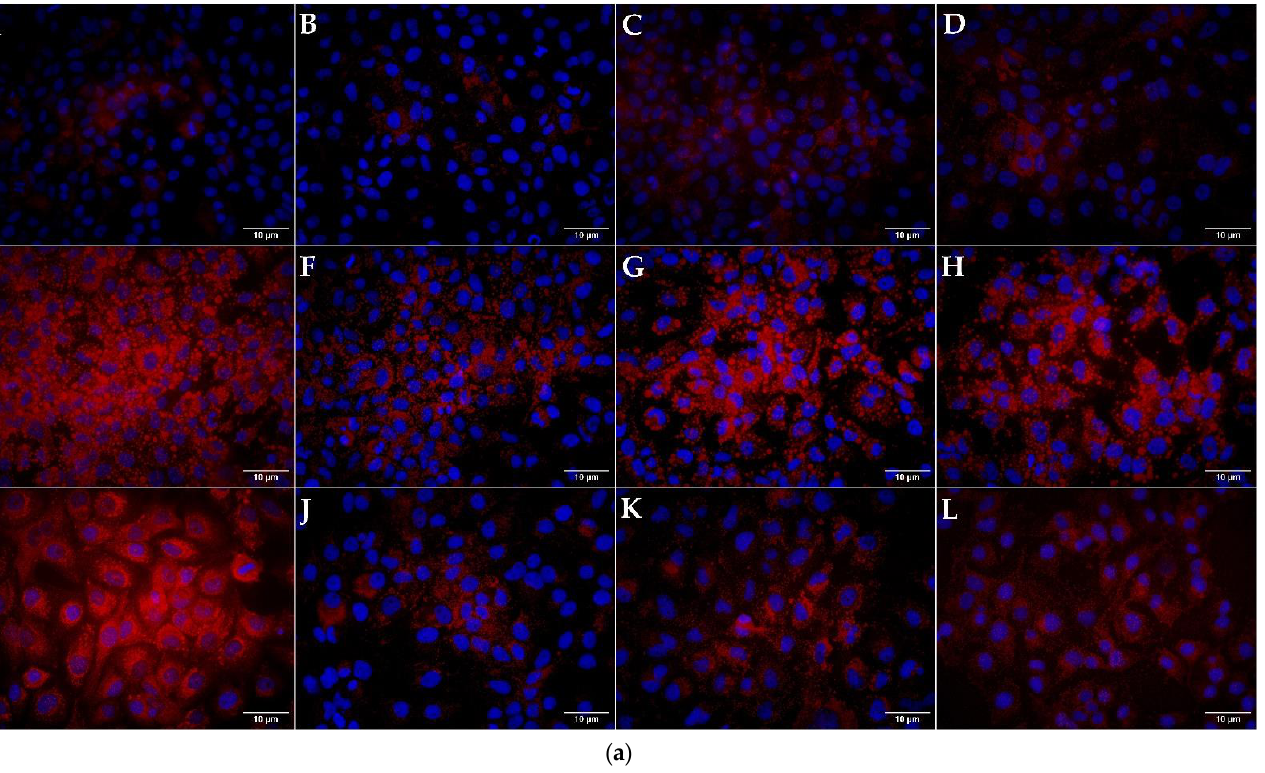
Figure 2. Determination of cell viability by MTT assay after exposure of Huh7 cells to OA, AMD and different LIRA concentrations for 24 h. MTT measurements were done by spectrophotometry at 595 nm. Results are shown as a percentage relative to the negative control of at least three biological replicates. One-way ANOVA F (11, 71) = 37.61; p = 8.38 × 10 − 23 Mann-Whitney pairwise. Bars assigned with asterisks indicate statistically significant differences (* p < 0.05, ** p < 0.01). Dulbecco’s modified Eagle’s medium (DMEM) as a negative control, liraglutide (LIRA/nM), oleic acid (OA/mM), amiodarone (AMD/ µ M).